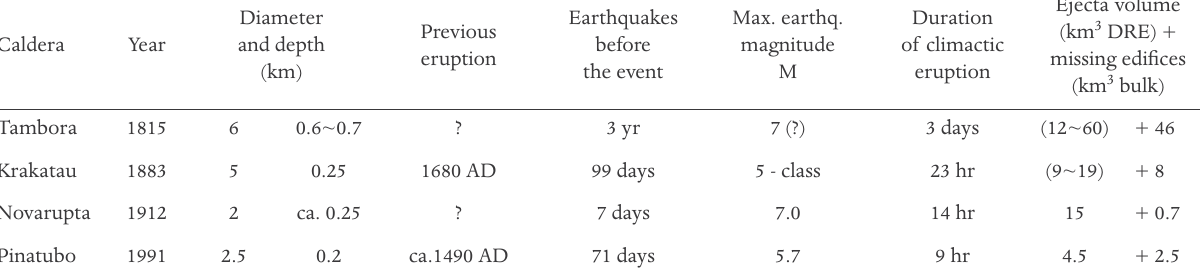
Table 1. Main features of the four calderas observed during and after the formation. The origins of the data are given in the paragraph of each caldera. DRE: dense rock